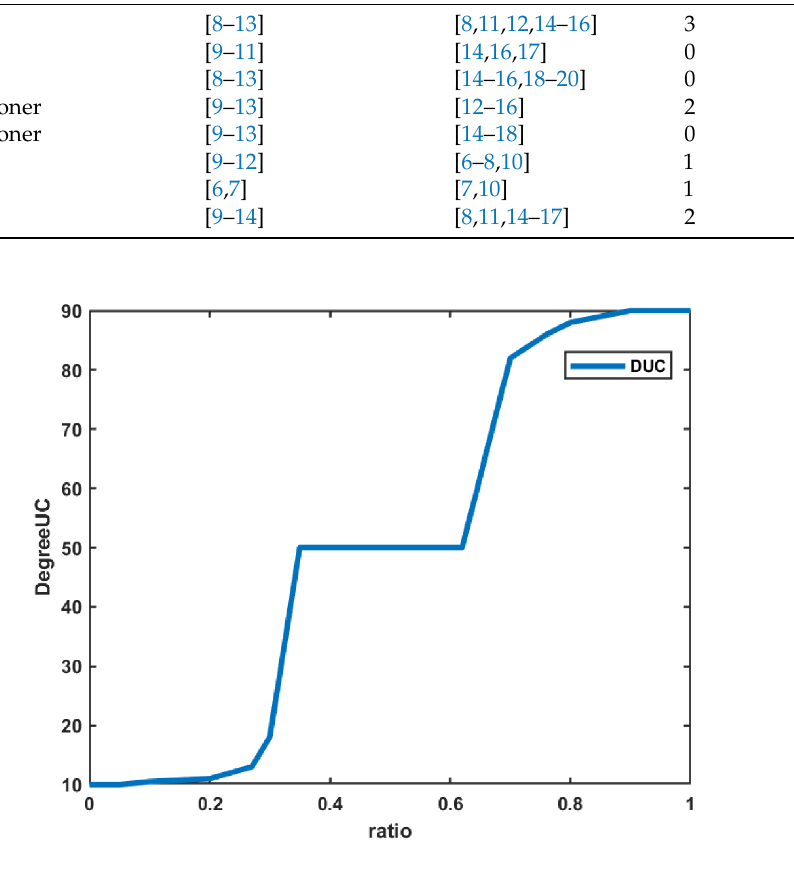
Figure 13. Increasing Degree of UC with the increase in ratio.